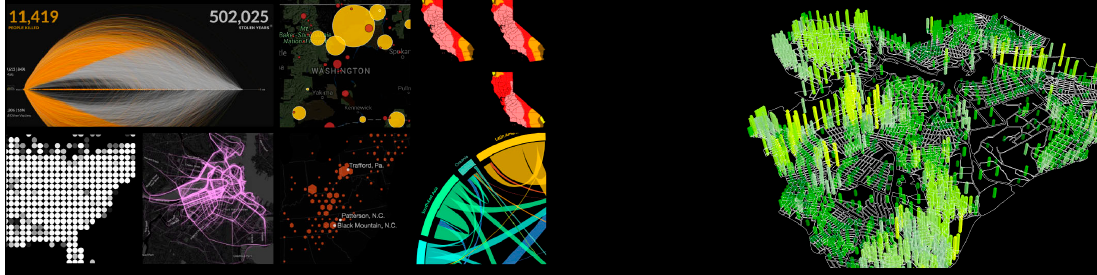
Figure 6. Images that stimulate the imagination of their user (visual design) and interactive images that support the imagination of the planner (processing and visualization of data on a territorial